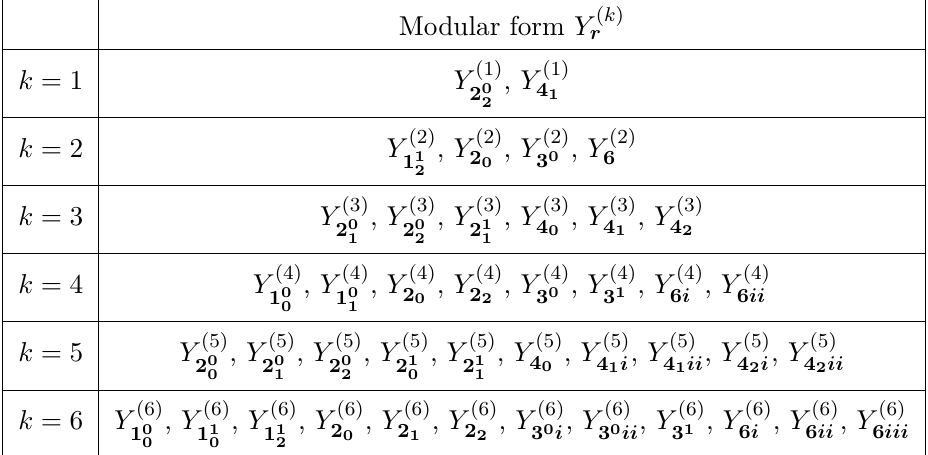
. Here Y (4) and Y (4) stand for two 6 6 i 6 ii and Y ( k ) are modular forms of level 2 [14], 2 0 1 r 0 , Y ( k ) and Y ( k ) are modular forms of level 3 [59], where the indices 3 0 1 0 2 0 k k